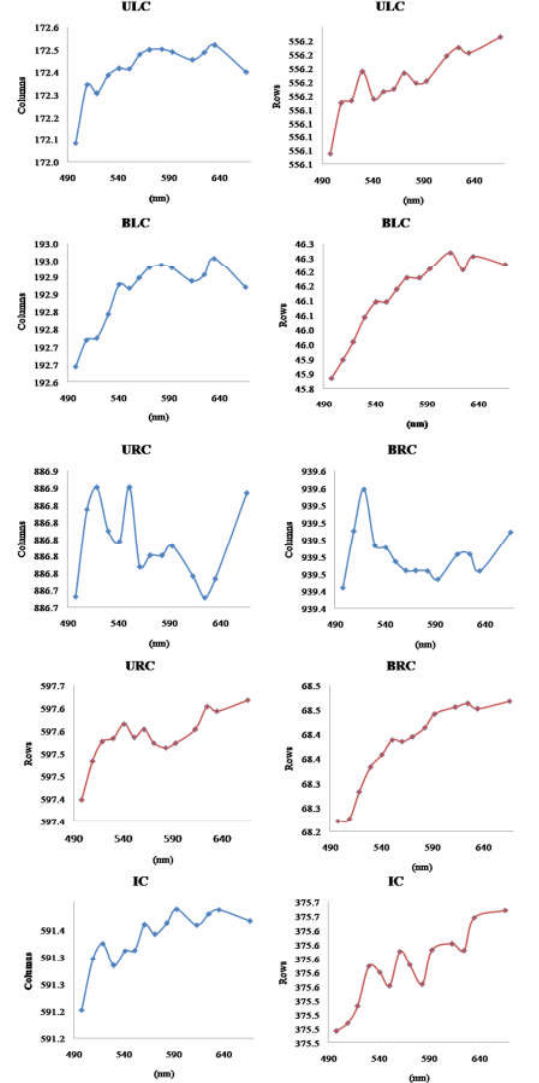
Figure 3. Effect of air-gap variation in the image coordinates of targets for sensor